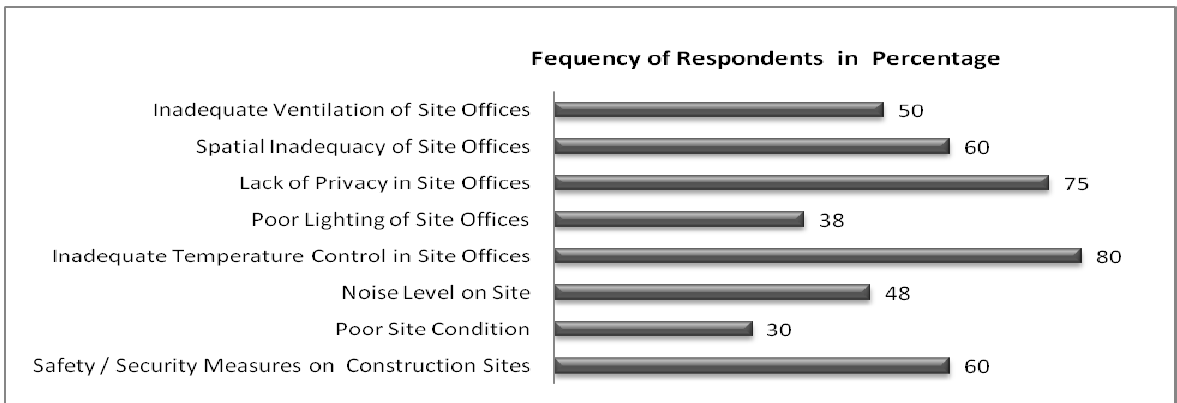
Figure 2 Physical work environment stressors (Source: Field work,